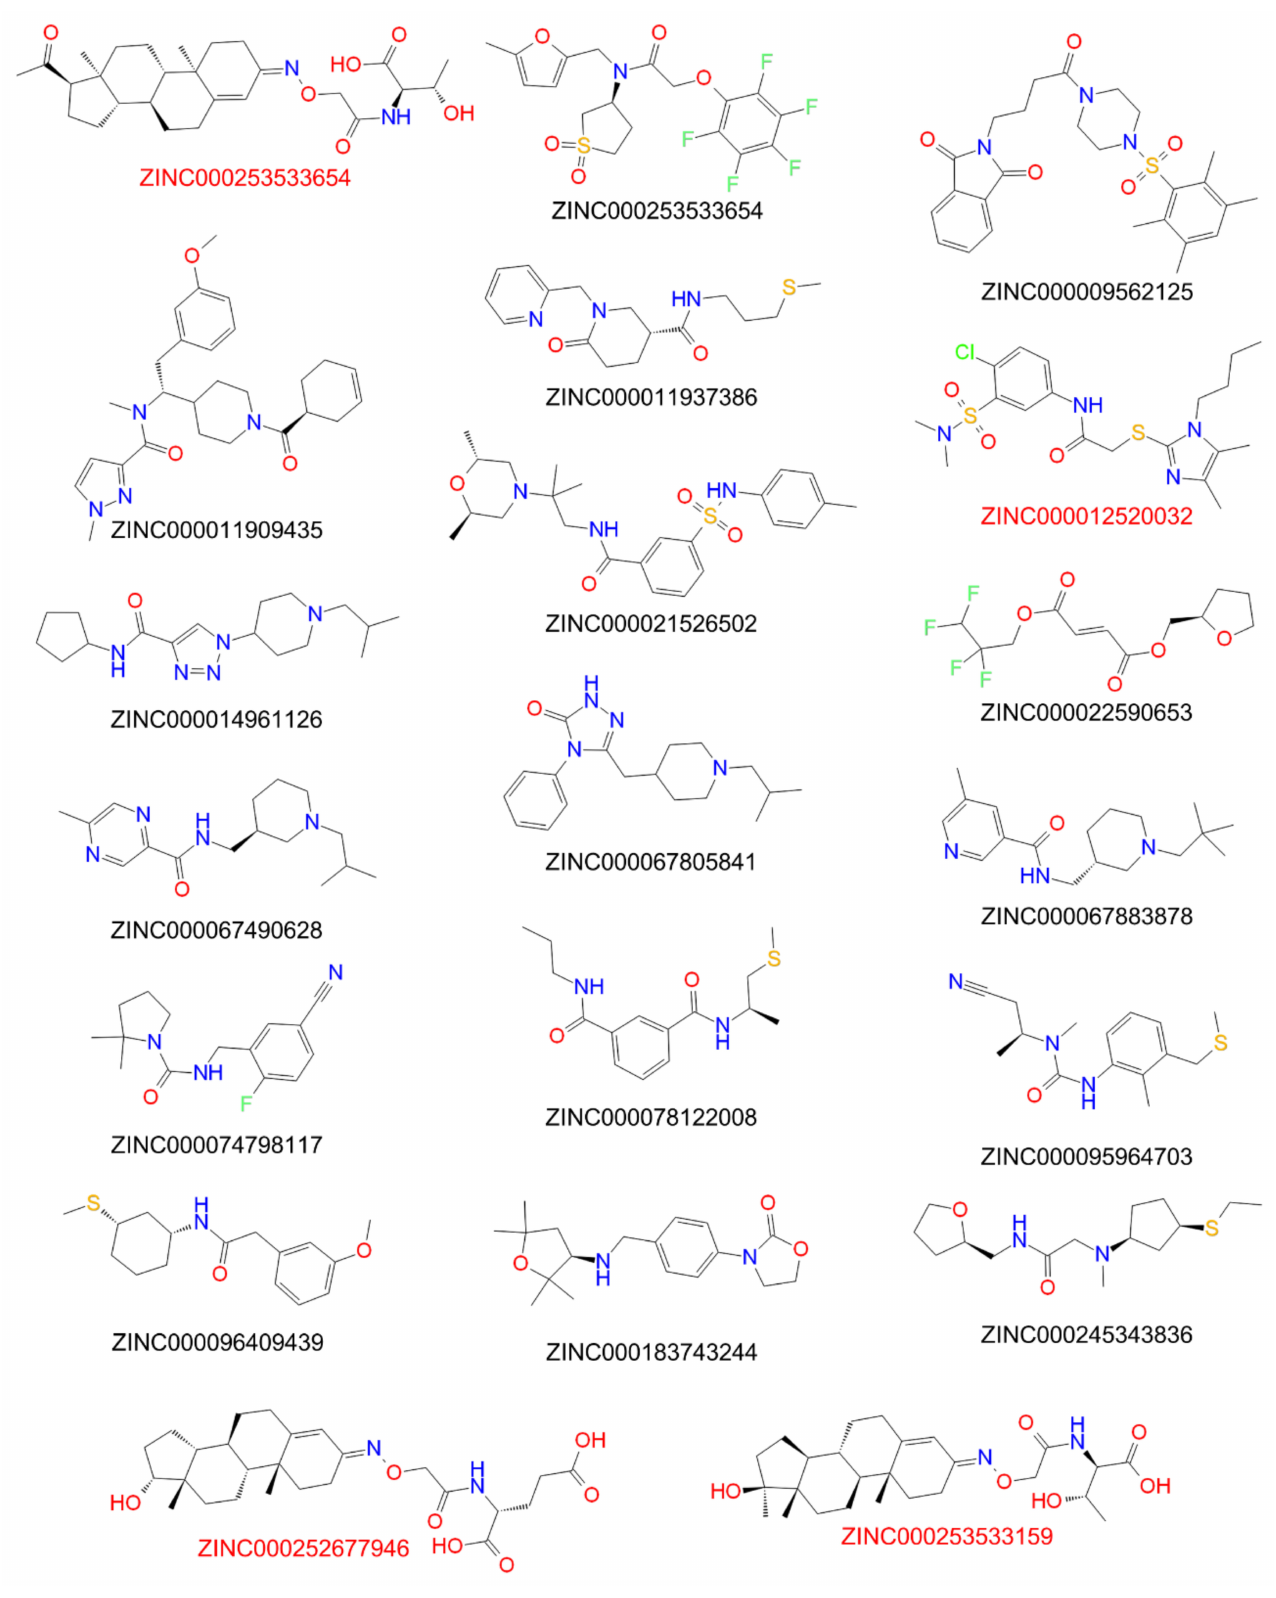
Figure 5. Structures of the top-20-hit compounds from virtual QSAR screening. Red-marked compounds proved anti-HDV activity (see Figure